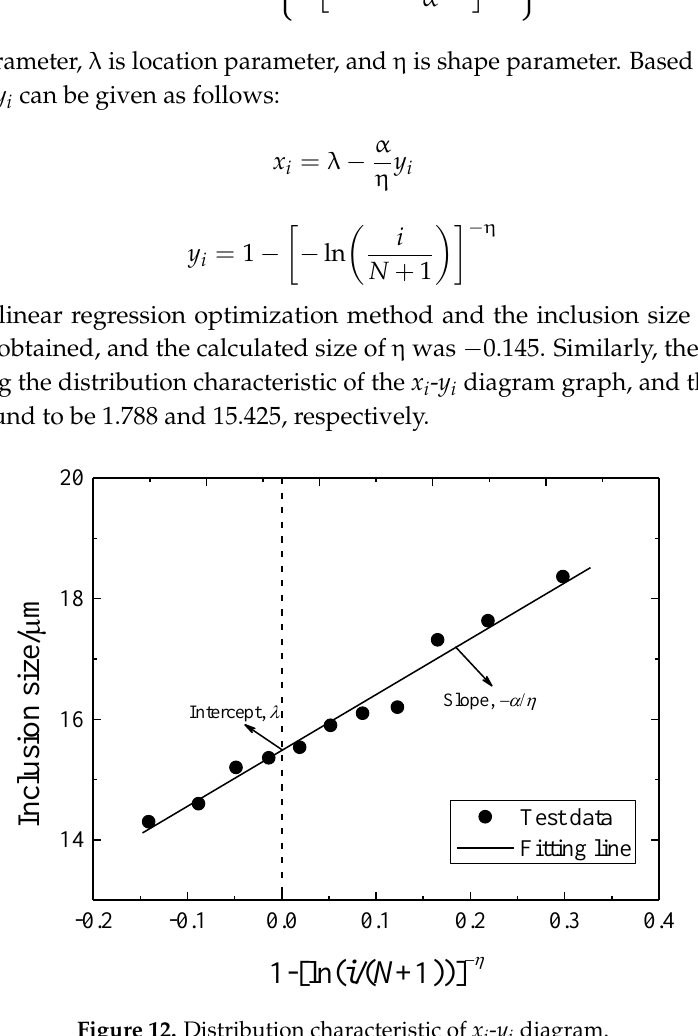
Figure 12. Distribution characteristic of x i - y i diagram.